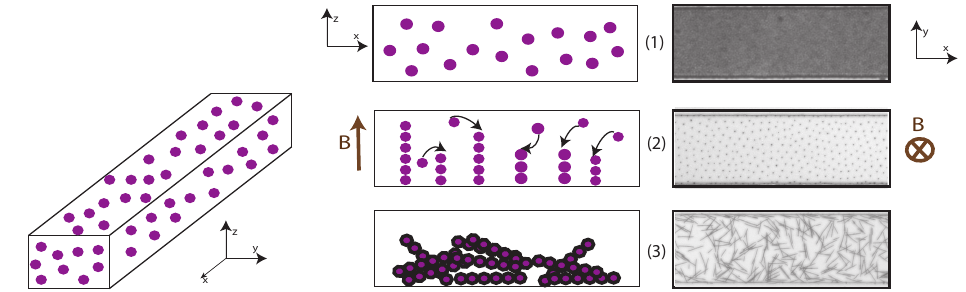
Figure 6. Principle of fabrication of fibers using super-paramagnetic colloids. Left drawings represent a vertical section view of the channel through the three steps of fabrication, illustrated on the right by frames of the channel captured from above on the microscope, extracted from an